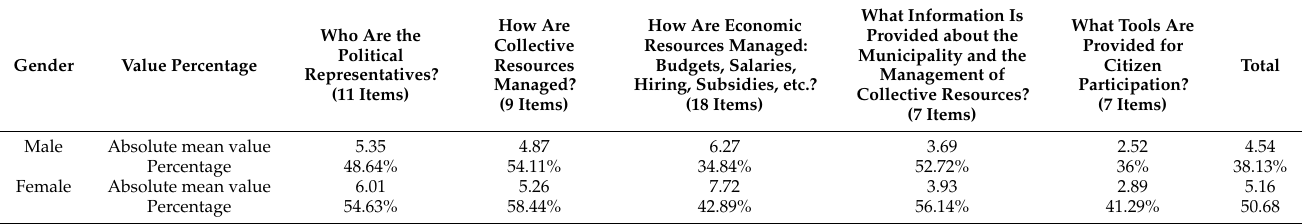
Table 3. Degree of compliance of indicators by sub-group cross-referenced with the gender of the mayor variable.